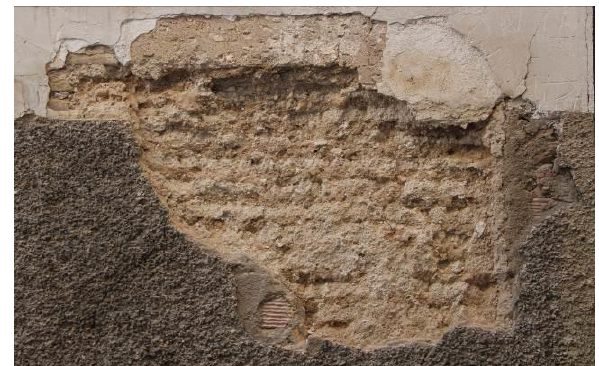
Figure 8. Detail of the lime layers of a lime-crusted rammed earth wall (Source: